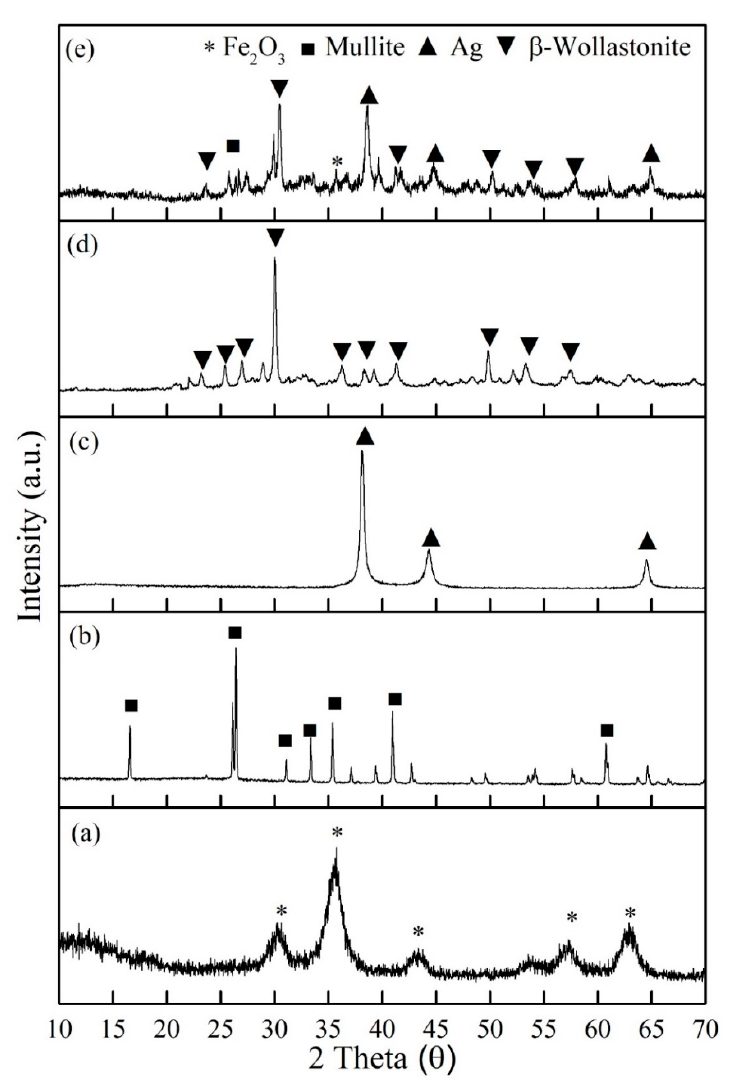
Figure 1. XRD analysis of all the raw materials; ( a ) maghemite ( γ -Fe 2 O 3 ), ( b ) mullite, ( c ) silver, ( d ) β W, and ( e ) β WMAF composite powders. ( d ) β W, and ( e ) β WMAF composite